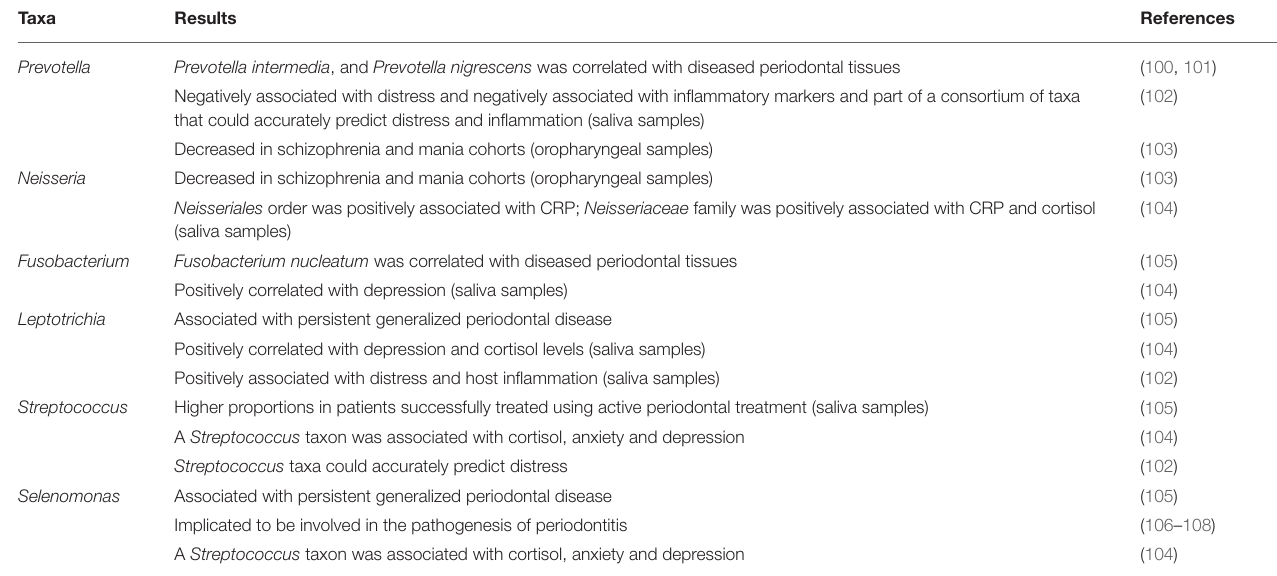
TABLE 3 | Summary of taxa implicated in periodontal diagnoses as well as anxiety disorders, depressive disorders, and trauma- and stressor-related